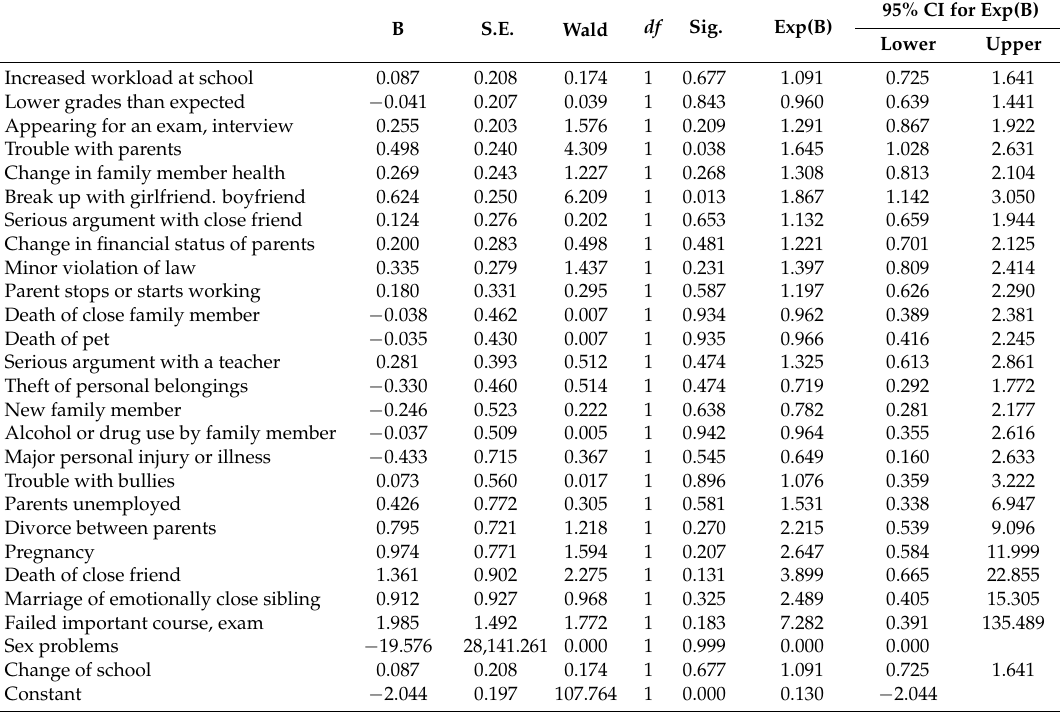
Table 3. D-SIB and individual life events in high school students.